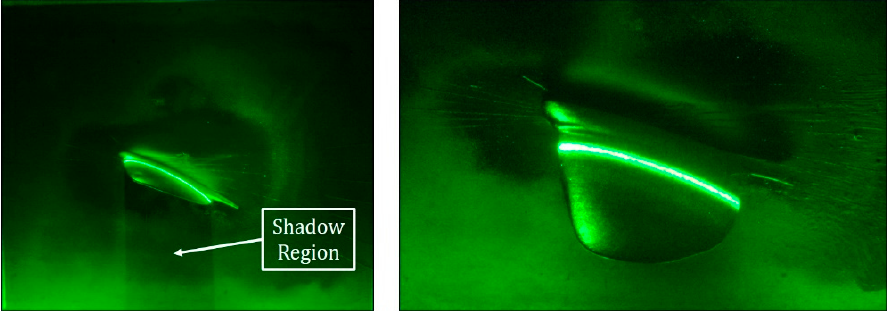
Figure 7. Photograph of the laser illumination on the model.